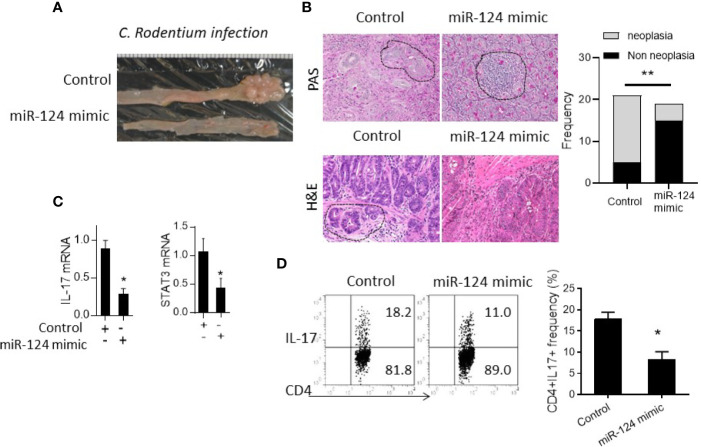
MiR-124 depressed the colon carcinogenesis in C. rodentium infection colitis-related cancer murine model. 8-week-old wild-type mice (WT; n = 12) infected orally with 2 × 109 colony-forming units (CFUs) of C. rodentium in the presence of control (n = 6) or miR-124 mimic (n = 6). (A, B) Morphology of intestines and representative H&E-stained sections and PAS after C. rodentium infection. Scale bar: 100 μm. **p < 0.01 versus recipients of miR-124 mimic treatment group. (C) Total RNA was extracted and mRNA was detected by qPCR, b-actin as control, *P < 0.05; (D) The percentage of IL-17-producing cells from mesenteric lymph nodes of mice in control and miR-124 mimic treated group. *p < 0.05 versus recipients of control treated group.